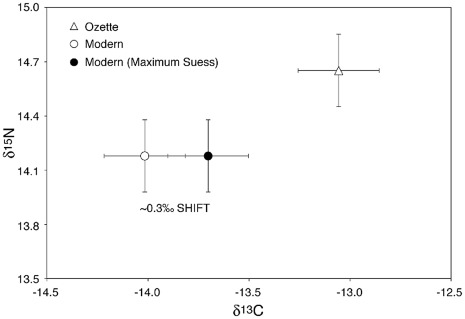
Mean stable isotope values for modern (USNM), modern corrected (USNM (maximum Suess)) and ancient (Ozette) samples; error bars represent standard errors.No significant overall difference between ancient and modern samples is observed once modern samples are corrected for the Suess effect. The Suess effect results in an average shift in δ13C of 0.3%.